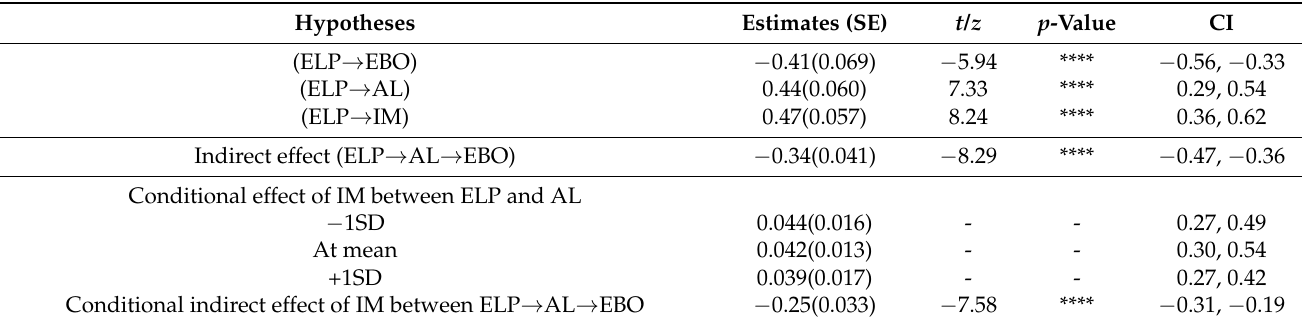
Table 6. Direct, indirect, and conditional